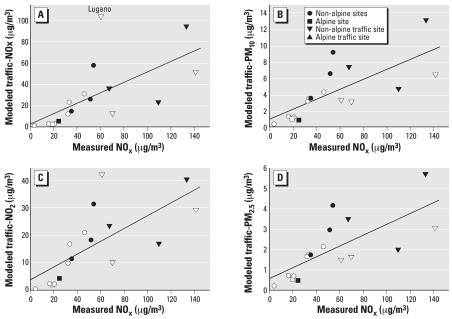
Relationship in 2000 between measured NOx and modeled traffic-related (A) NOx [background sites: y = −14 + 0.98x (R2 = 0.77, n = 11); traffic sites: y = 41 + 0.13x (R2 = 0.01, n = 6); all sites: y = 2 + 0.50x (R2 = 0.41, n = 17)]; (B) PM10 [background: y = −2 + 0.16x (R
2 = 0.84, n = 11); traffic sites: y = 0.4 + 0.06x (R2 = 0.35, n = 6); all sites: y = 1 + 0.06x (R2 = 0.54, n = 17)]; (C) NO2 [background: y = −7 + 0.59x (R
2 = 0.85, n = 11); traffic sites: y = 20 + 0.08x (R2 = 0.04, n = 6); all sites: y = 4 + 0.24x (R2 = 0.50, n = 17)]; and (D) PM2.5 [background: y = −0.7 + 0.07x (R2 = 0.86, n = 11); traffic sites: y = 0.4 + 0.03x (R2 = 0.34, n = 6); all sites: y = 0.6 + 0.03x (R2 = 0.53, n = 17)]. SAPALDIA sites are in white.